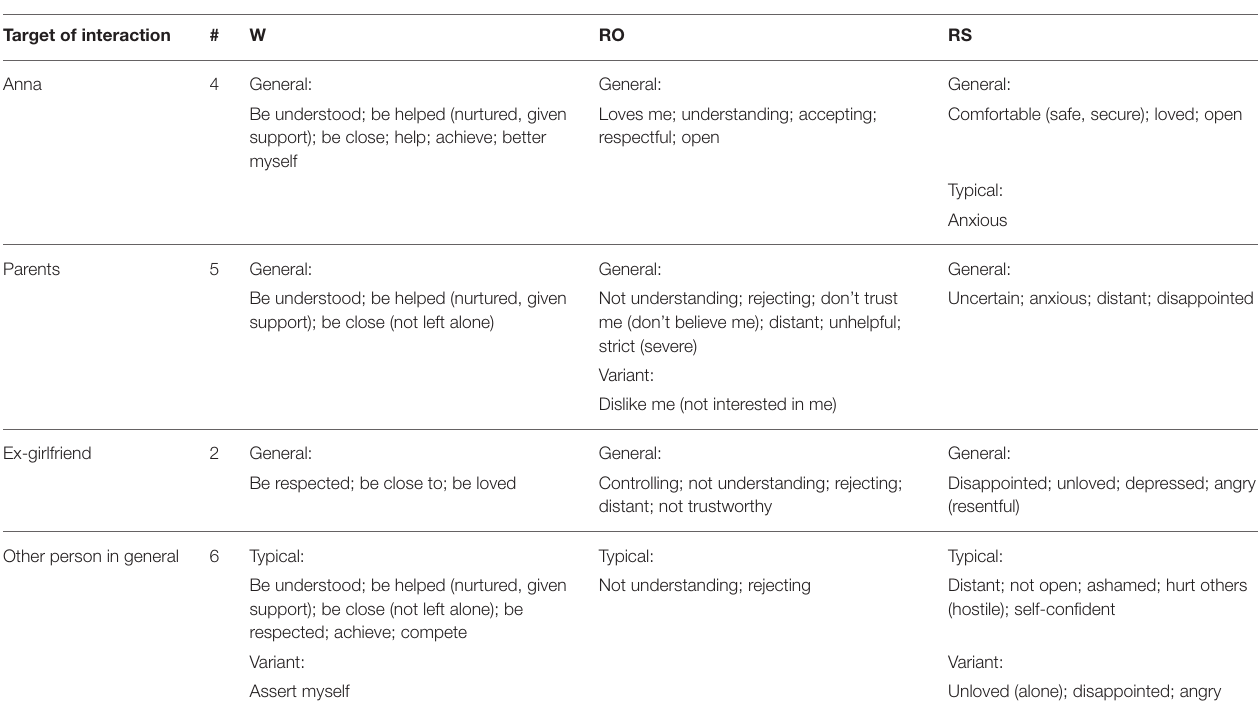
TABLE 4 | Patient’s wishes (W), responses of other (RO), and responses of self (RS) in sessions 21–23. Target of